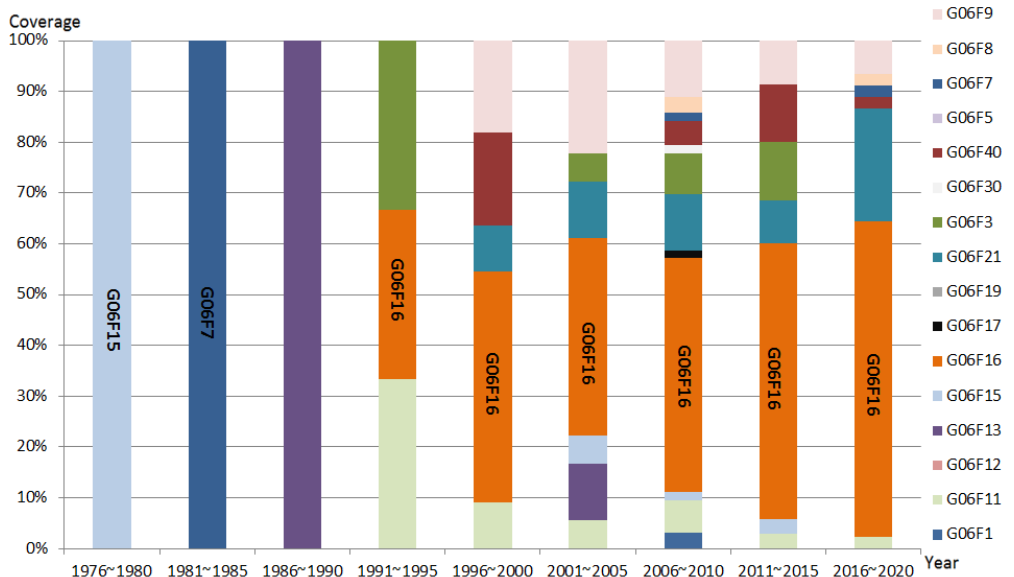
Figure 4. Sub-classification of G06F codes of software patents affecting all accounting information systems ’ patents by year.